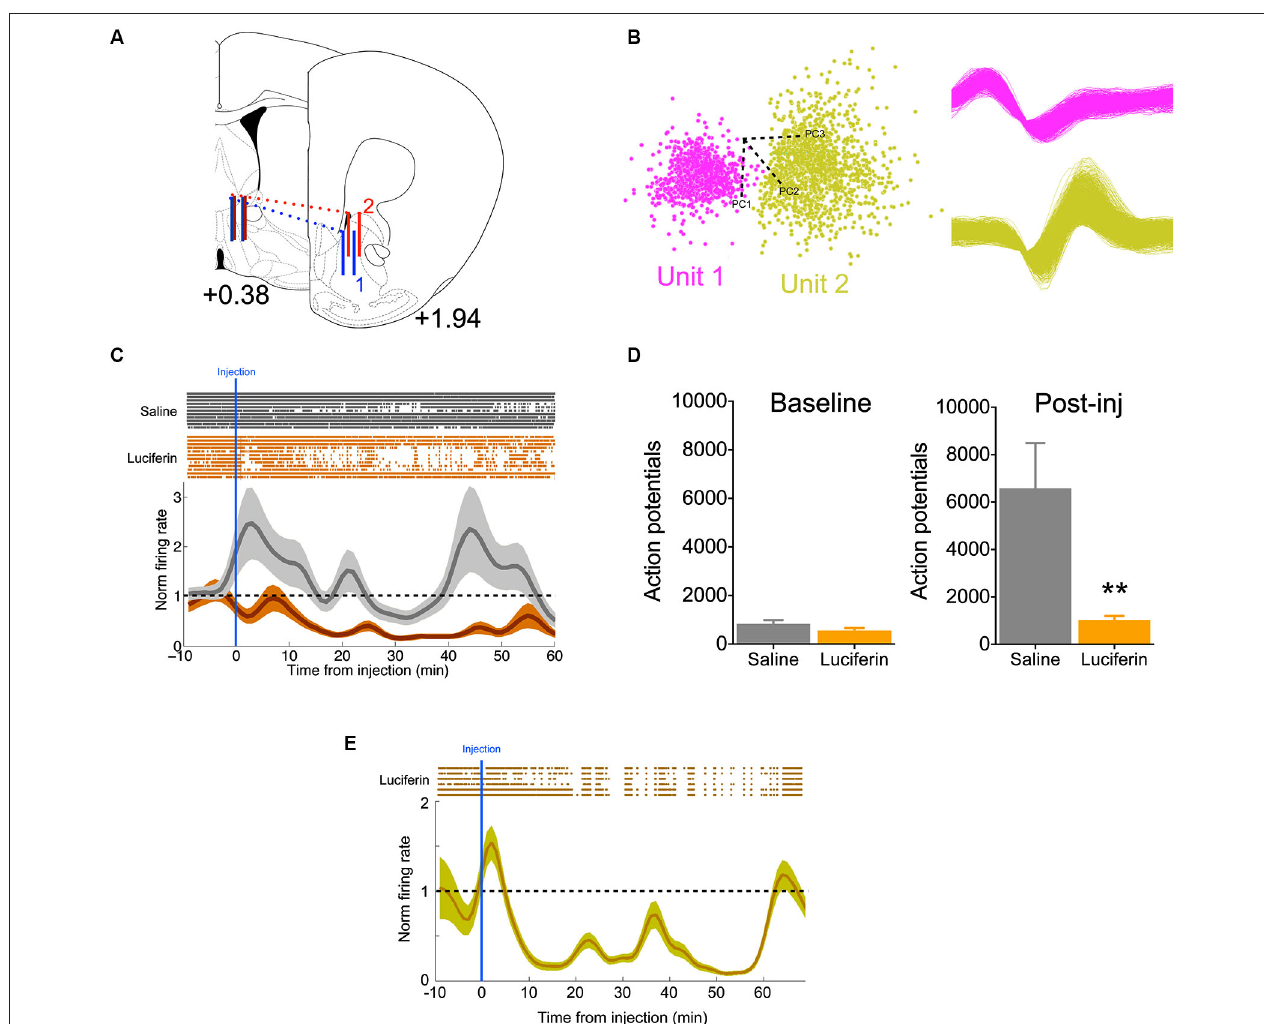
11) and luciferin (orange, n = 12) injected conditions over the timecourse of the experiment. Bottom, normalized firing rate over the same period. Note that while the saline condition remains around the baseline, luciferin injection produces a prolonged decrease in firing. (D) Left, total number of action potentials during the baseline period (10 min). Right, total number of action potentials after injection (60 min, n = 11,12 for saline and luciferin, respectively). (E) Top, rastors depicting action potentials for the luciferin-injected condition ( n = 6). Bottom, normalized firing rate over the course of the experiment. ** P <